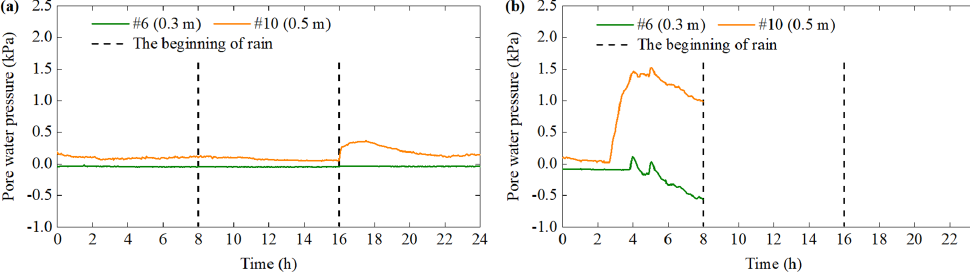
Figure 17. Pore water pressure at position C of (a) test 5 and (b) test 6.